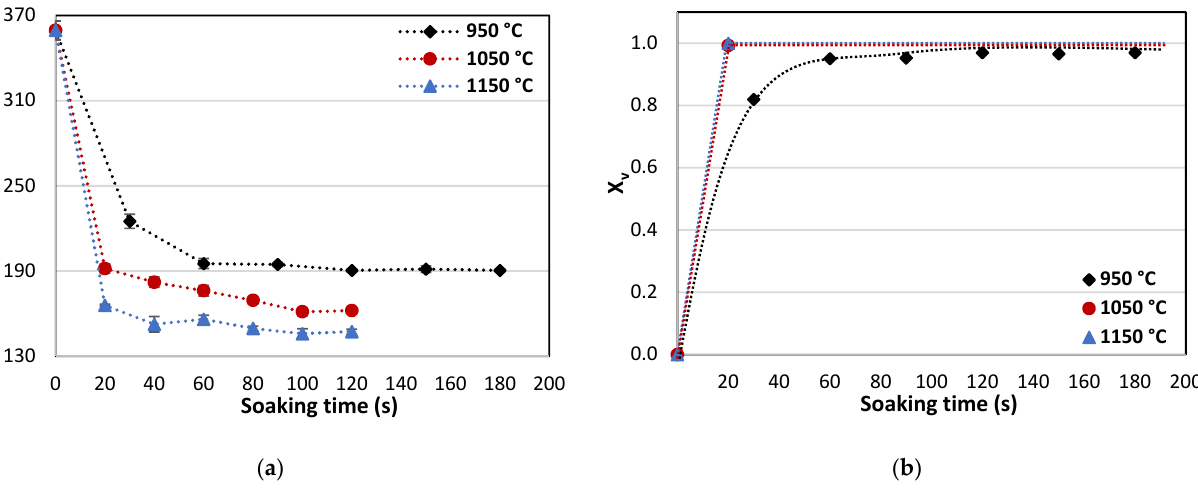
( b ) Figure 11. AISI 904 steel after cold rolling at 80% and annealing at ( a ) 1050 °C for 20 s and ( b ) 1150 °C for 20 s. Table 3. The average grain size for the recrystallized material for different process parameters. Annealing Temperature (°C)